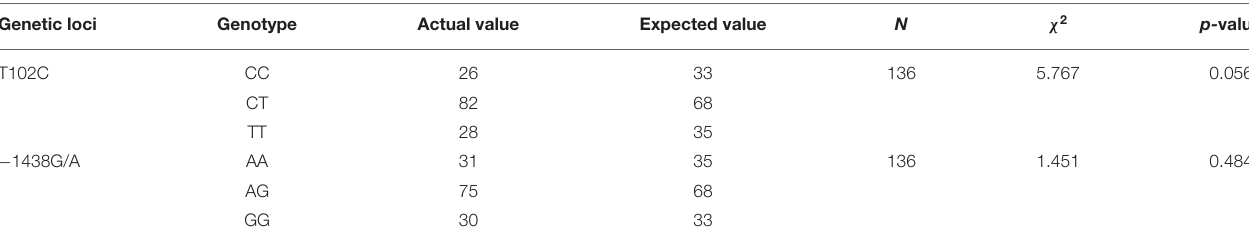
TABLE 5 | Hardy-Weinberg genetic equilibrium test. Genetic loci